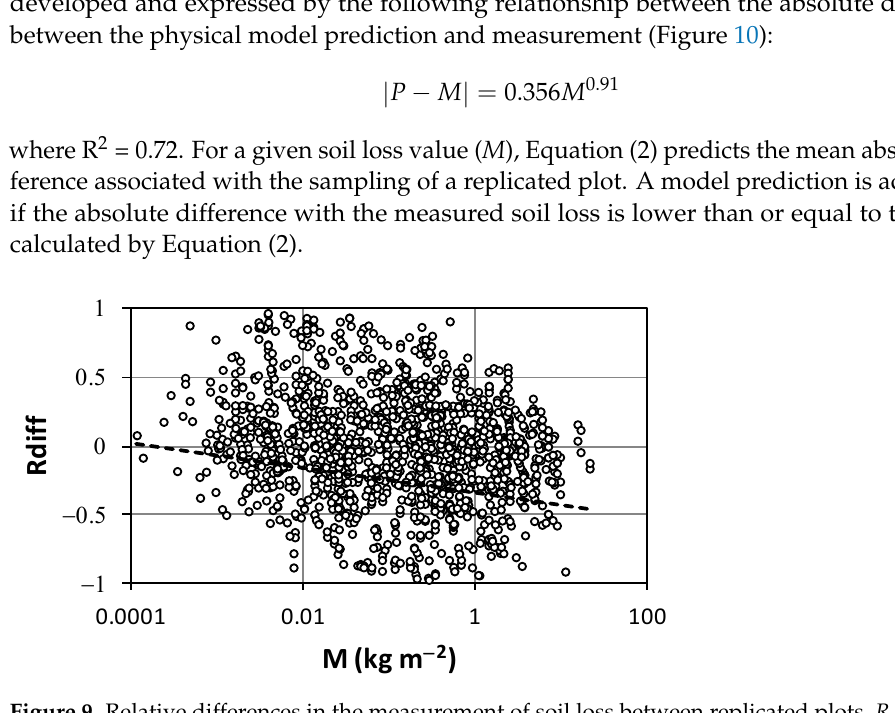
Figure 9. Relative differences in the measurement of soil loss between replicated plots, R diff , vs. the measured soil loss value, M , for all plots established at the Sparacia and Masse stations (modified from [41]).